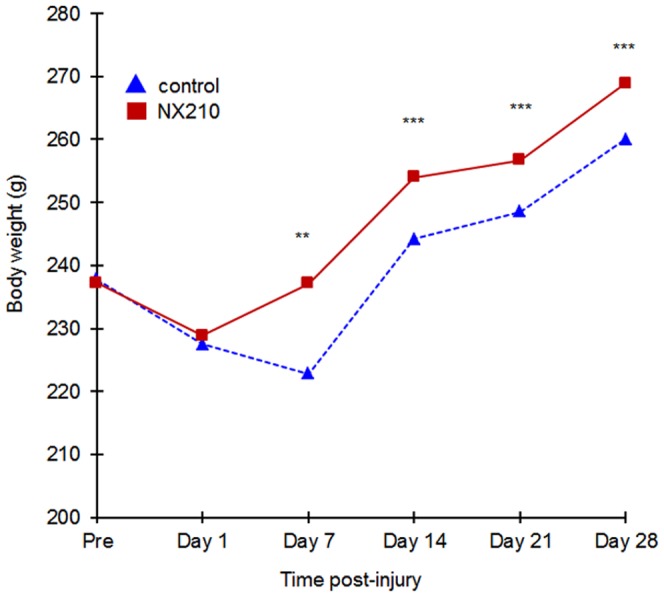
Effects of NX210 on functional recovery after SCI: body weight.A contusion was performed with the NYU/MASCIC impactor. The body weight was measured once a week over the month of the study. NX210-treated group (n = 8) in solid red line, vehicle group (n = 8) in blue dashed line. NX210 treatment induces a significant increase in body weight from D1, reaches the pre-injury value at D7 and keeps increasing until the end of the study. In sharp contrast, the body weight of the control group decreases in the first week, starts to increase at D7, reaches the pre-injury value at D14 but remains inferior to the body weight of the treated group throughout the study. Data are presented as mean ± SEM. Significantly different from baseline value, ** p<0.05 and *** p<0.001.